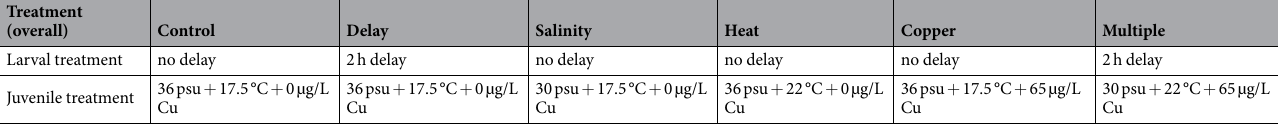
Table 1. Stressor manipulations: how the six stressor treatments were